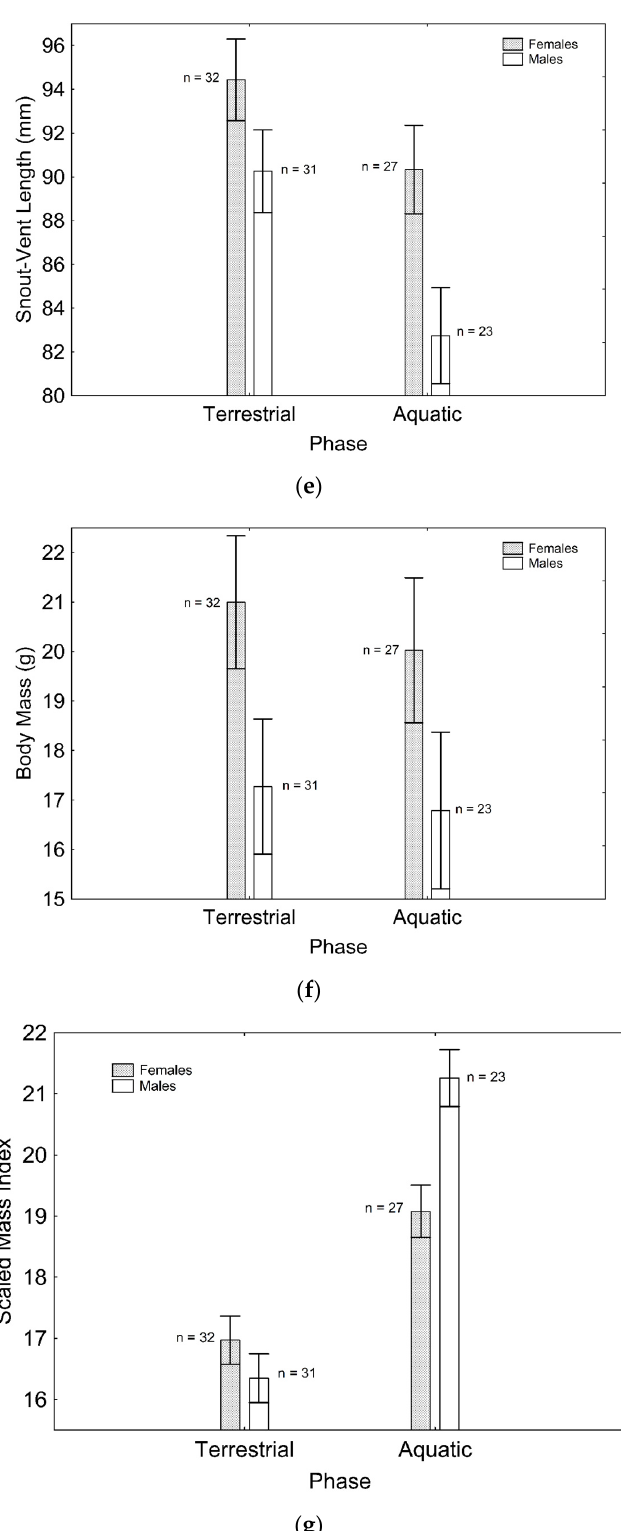
Figure 1. Effects of phase and sex on relative speed ( a ), relative forelimb length ( b ), relative hindlimb length ( c ), relative tail length ( d ), SVL ( e ), body mass ( f ), and SMI ( g ). Sample sizes are indicated. Vertical whiskers represent standard errors.